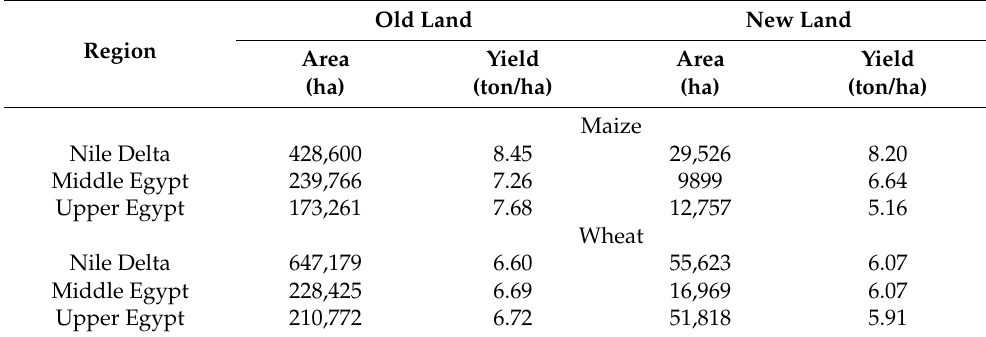
Table 1. The five years means of cultivated area and yield for wheat and maize in the three regions. Old Land New Land Region Area Yield (ha)